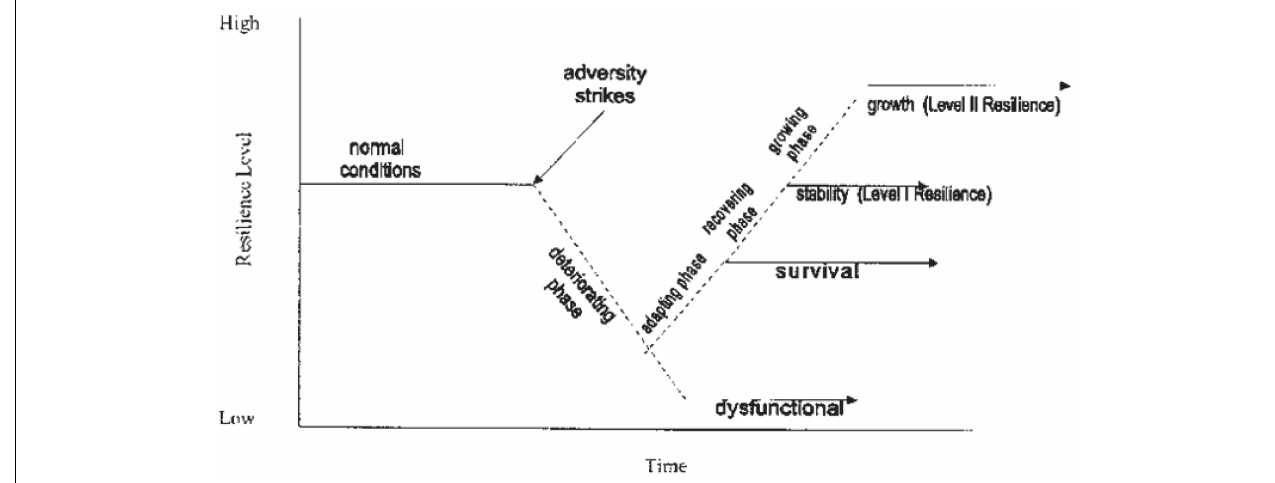
FIGURE 1 | Resilience Cycle.